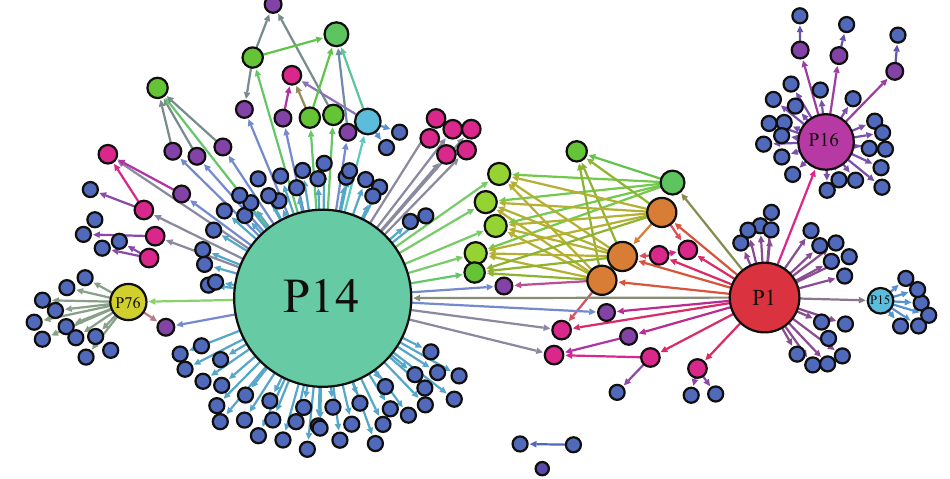
Figure 2. Transmission trees are displayed (the only infection tracing shown). The node size is proportional to the number of secondary infection cases (five superspreaders are identified).